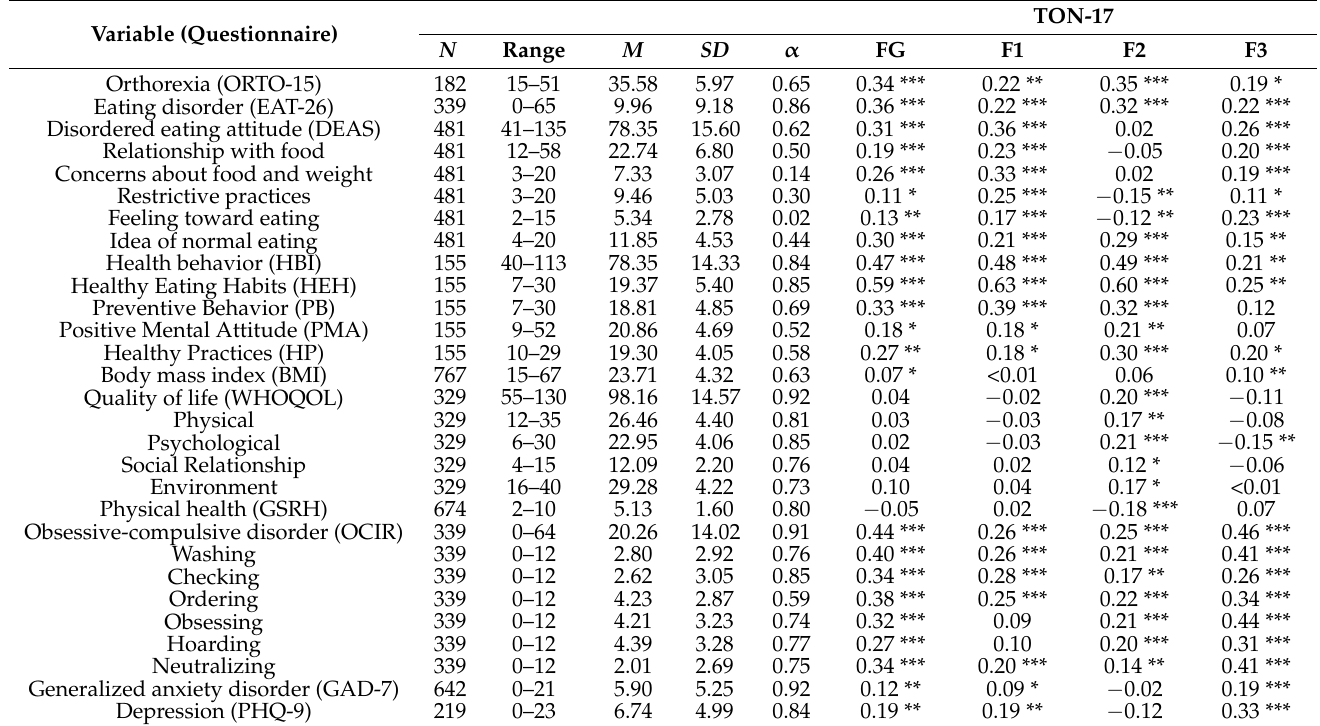
Table 6. Correlations of the TON-17 scales (Total, F1, F2, and F3) with other